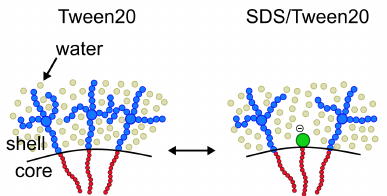
Figure 4. Surfactants are assumed to homogeneously distribute and form mixed nonionic–anionic micelles, as visualised for SDS/Tween20 mixtures.